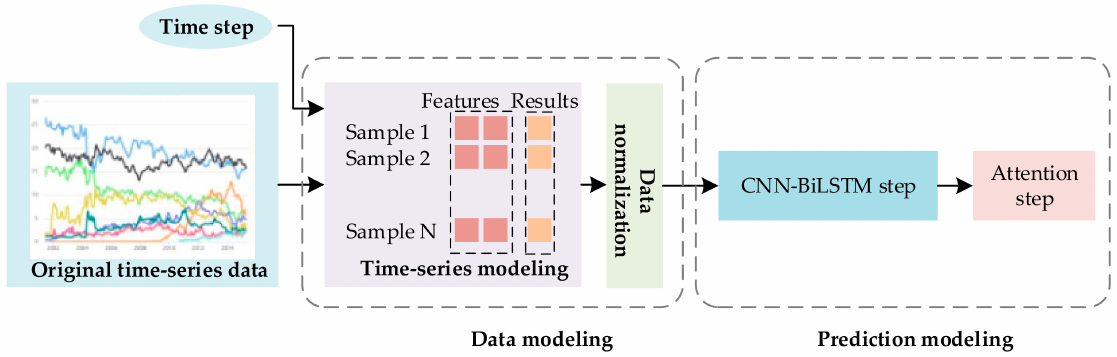
Figure 1. The framework of CNN-BiLSTM-Attention.